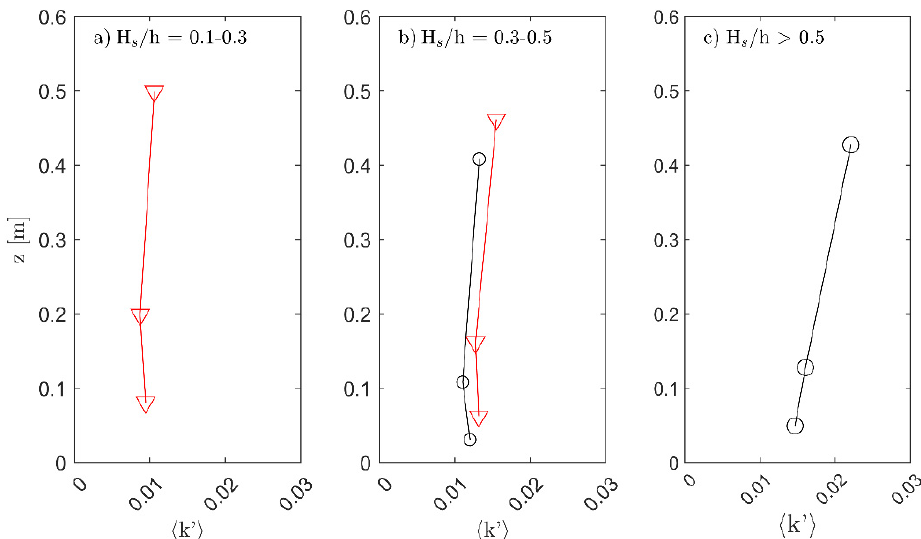
Figure 8. Vertical structure of < k ’> for non-breaking waves ( γ s = 0.1–0.3, panel ( a )), weakly breaking waves ( γ s = 0.3–0.5, panel ( b )) and strongly breaking waves ( γ s > 0.5, panel ( c )). z is elevation above the seabed. Black symbols are from Durras Beach, NSW, Australia and red symbols are from Vejers Beach, Denmark. From Christensen et al. [74].